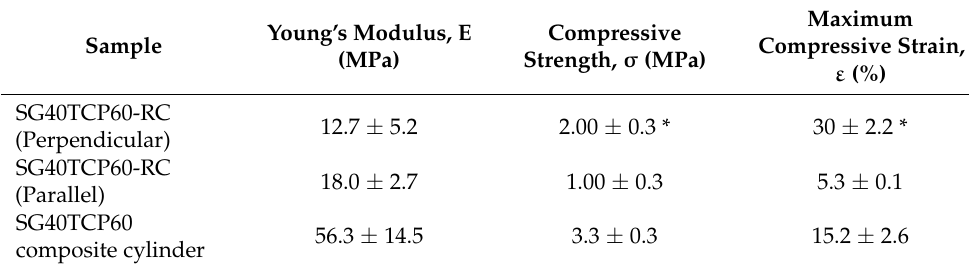
Figure 5. Stress–strain curves from the uniaxial compression test: ( a ) load directions; ( b ) SG40TCP60-RC scaffold in perpendicular and parallel (inset) load directions to the printing plane; ( c ) SG40TCP60 composite cylinder specimen. Table 2. Mechanical properties from the uniaxial compression test of the SG40TCP60-RC scaffold and SG40TCP60 composite cylinder; mean values ± standard deviation ( n = 3 in all cases).